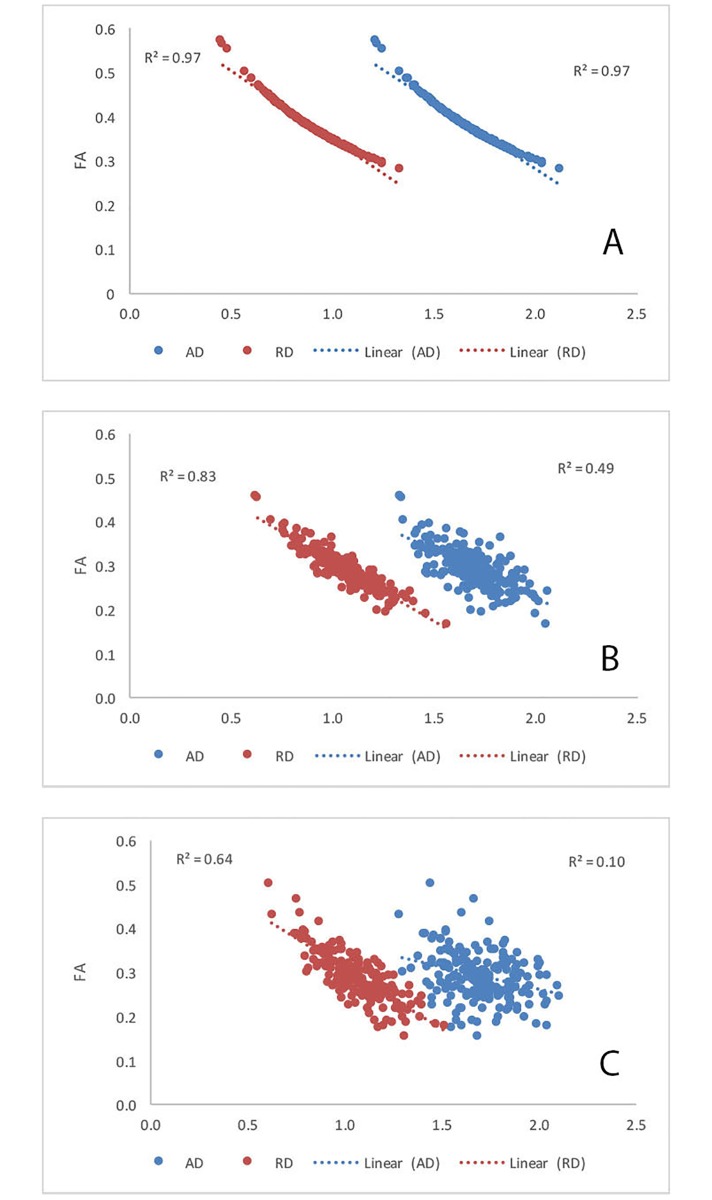
Simulated correlation between anisotropy (FA) and parallel and perpendicular diffusivities (AD and RD): a) stage 1: the expansion of ECS b) stage 2: addition of “membranal” component c) stage 3: addition of inter-subject noise.Horizontal axes represent diffusivity values x10−3 mm2 s−1.